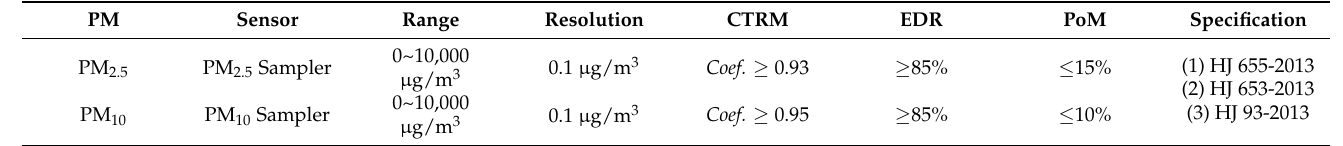
Table A4. Parameters and Specifications of the sensors to measure PM 10 and PM 2.5